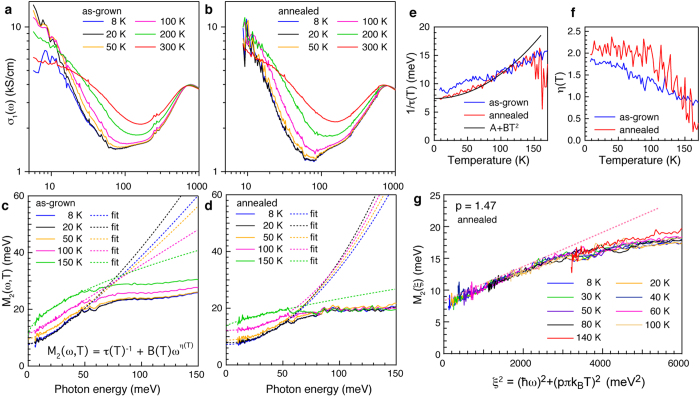
Experimental determination of Fermi liquid behaviour in electron doped BaFe2As2.(a,b) Comparison of the real part of the optical conductivity σ1 (ω) for as-grown (Tc ≈ 18 K) and annealed (Tc ≈ 25 K) Ba1.8Fe0.2Co2As2 at selected temperatures. The most significant annealing induced change is a reduction of a broad incoherent background that is most clearly seen by the deeper minimum around 70 meV separating the free charge and inter-band optical conductivity. (c,d) Imaginary part of the memory function, M2 (ω, T), revealing the difference in free charge response for as-grown and annealed crystals. The memory function is obtained by subtracting the full interband response as discussed in the text and SOM. Dashed curves indicate fits made using the fitting function indicated in panel c. (e) Temperature dependence of the static scattering rate 1/τ (T) obtained from the fits in panels (c,d). For the annealed crystal 1/τ (T) displays a T2 behaviour below T~100 K as indicated by the fit. (f), Temperature dependence of the exponent, η (T), extracted from the fits in panel (c,d). The exponent for the annealed crystal shows ω2 dependence in the same temperature range where 1/τ (T) has a T2 temperature dependence. At higher temperatures a clear deviation from Fermi liquid behaviour is found. (g) Scaling collapse obtained by plotting M2 (ω, T) as M2 (ξ), where ξ2 = ()2 + (1.47πkBT)2. Above ξ2 ≈ 2500 meV2 the scaling deviates from the universal Fermi liquid behaviour which is indicated by the dashed pink line.